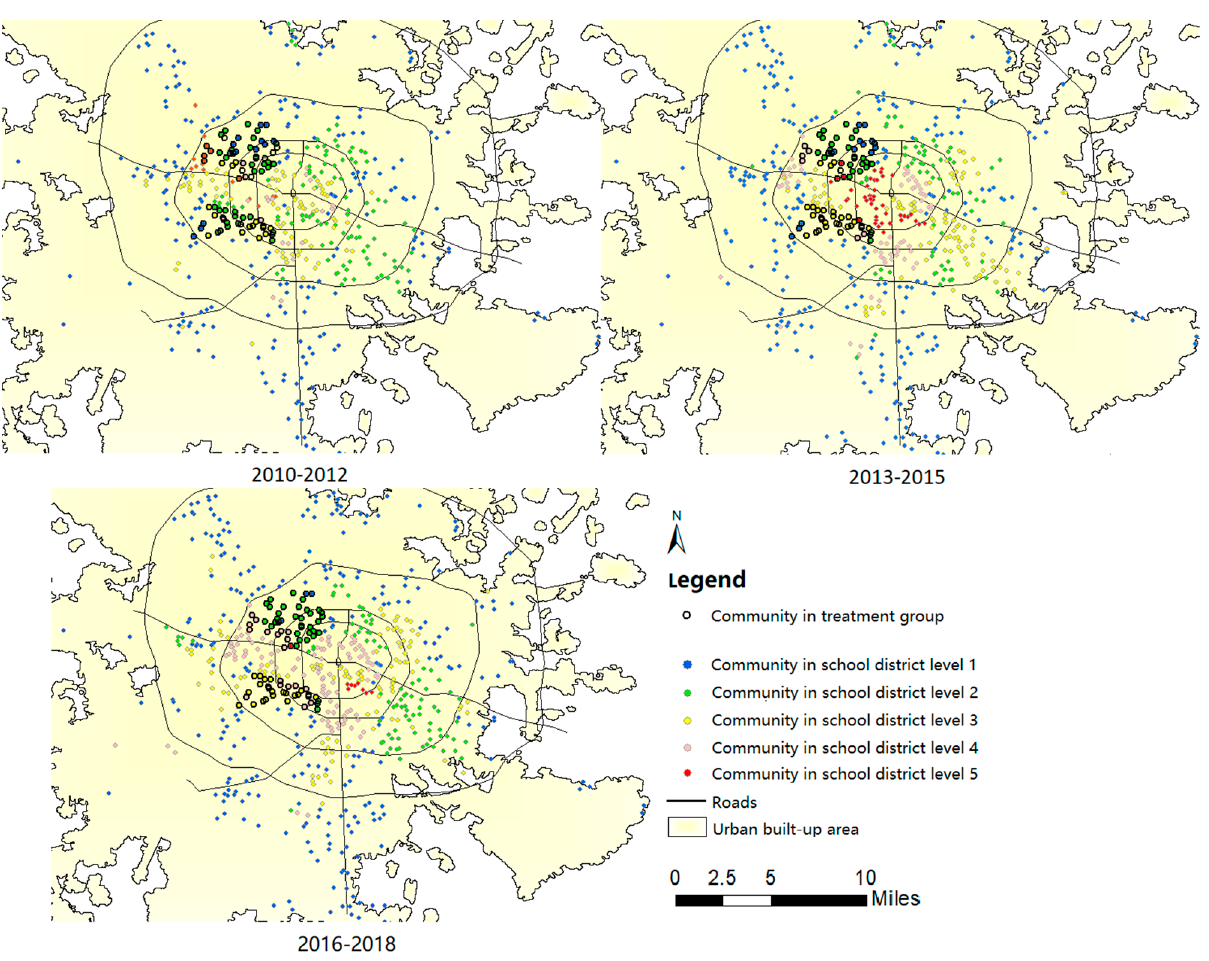
Figure 2. Distribution of study samples and their educational quality. 6